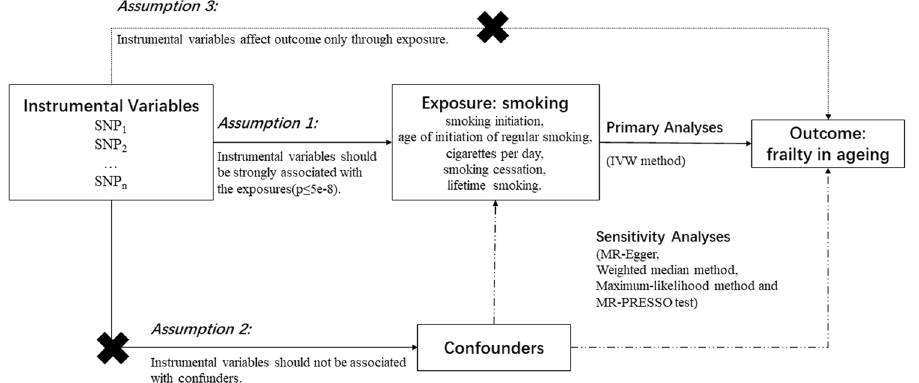
Figure 1. An overview of the study